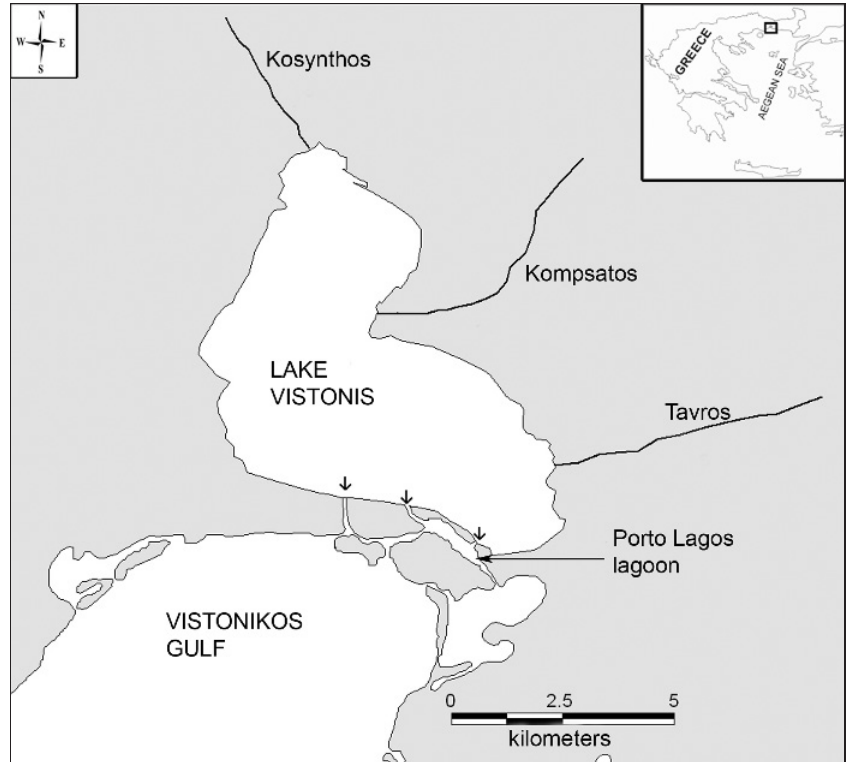
Fig. 1. Map of the study area. Arrows indicate connection with the Porto Lagos Lagoon and the Vistonicos